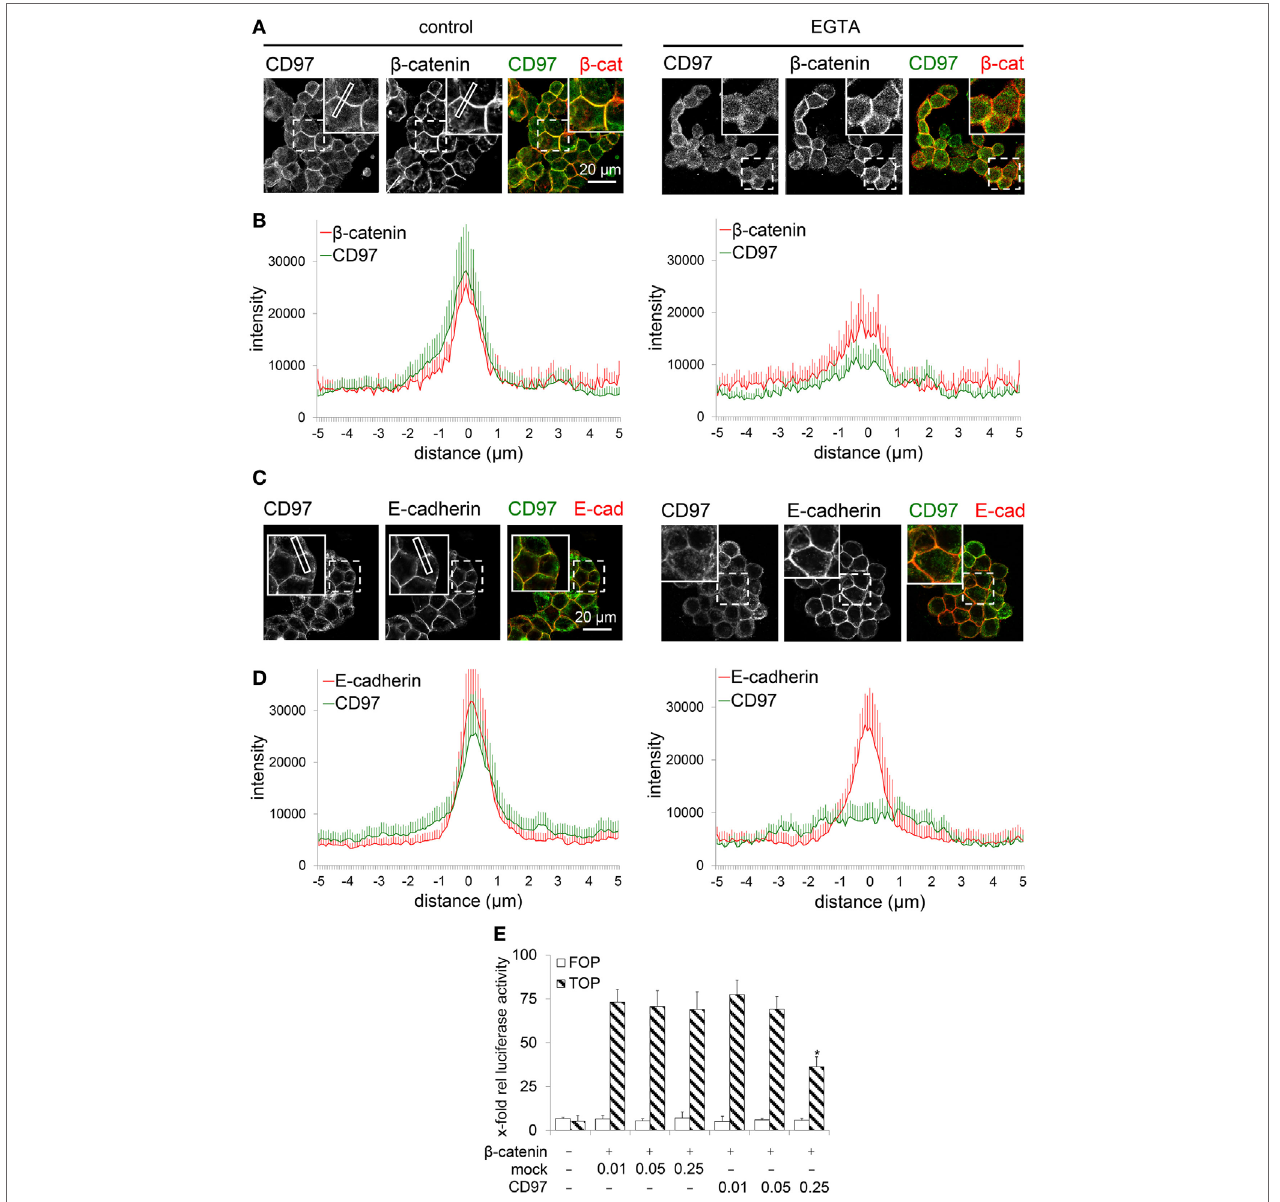
FigUre 6 | CD97 does not regulate nuclear β -catenin function. (a,c) In WiDr cells overexpressing a CD97-EGFP fusion protein, treatment with 3.2 mM EGTA over 20 min partly translocated CD97-EGFP into the cell, whereas β -catenin (a) partly and especially E-cadherin (Ecad) (c) still remained in the cell contacts as seen in the inserts of the pictures. As an example, a plot profile is indicated where the distribution of the various proteins has been quantified. (B,D) . The distribution of CD97 and β -catenin (B) as well as CD97 and Ecad (D) was analyzed in microscopic images. The staining intensity was quantified in plot profiles of 10 µm across the junctions using Fiji ( n = 10 junctions, mean ± SEM; 0 = junctional midpoint). (e) CD97(EGF125) did not change β -catenin-dependent TCF-mediated transcriptional activity in a dual luciferase reporter assay with HEK293 cells (pTOPFLASH, TOP; pFOPFLASH, FOP). At high CD97 concentration (micrograms/well) even an inhibitory effect was seen (mean ± SEM, n = 4, * p < 0.05 mock to